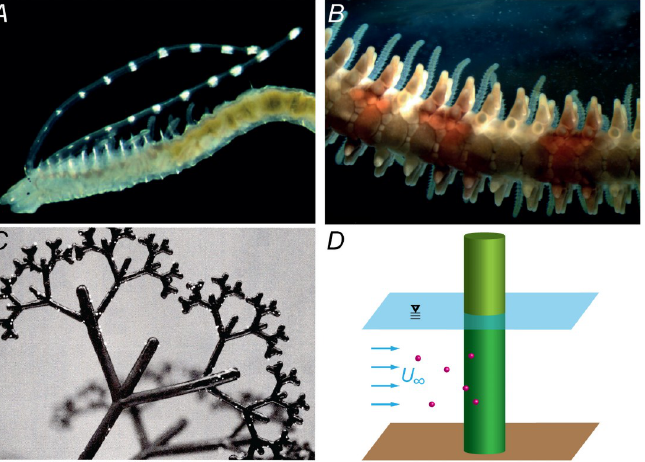
Fig 1. Examples of the particle collectors employed in laboratory and numerical experiments. ( A ) Pair of long palps (visible as tentacles with white pigment spots) of a spionid polychaete (e.g. [7, 17], photograph by L. Harris). ( B ) Multiple tube feet in the arm of a brittle star (e.g. [5], photograph by J. Sones). ( C ) A branched model collector emulating filamentous red algae [13]. ( D ) A rigid cylinder employed as an archetypal collector structure (e.g.